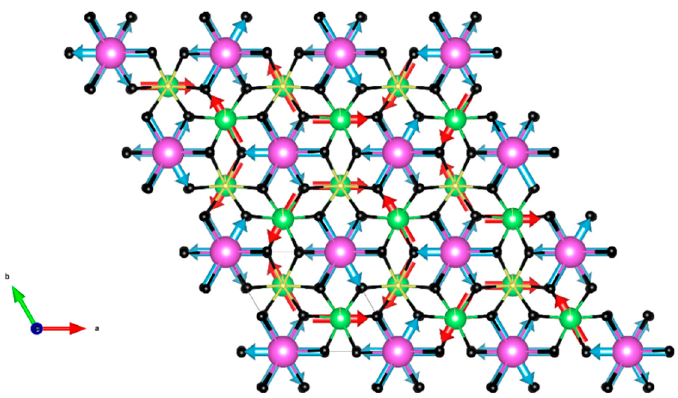
Figure 6. The ball-and-stick representation [20] of the crystal structure of GdFeTeO 6 . Purple, green, gray and black spheres are Gd, Fe, Te and O ions, respectively. Blue and pink arrows highlight the clockwise and anticlockwise arrangements of spins in different magnetoactive layers. Supplementary Materials: The following are available online at https://www.mdpi.com/article/ 10.3390/ma14205954/s1, Figure S1. Comparison of the two XRD patterns of nominal “GdFeTeO 6 ” taken in CuK α radia-tion. Upper panel: Relatively pure phase prepared from oxides for 48 h at 700 ◦ C [5]. Lower pan-el: mixed phase prepared by the semi-wet method for 56 h at 750 ◦ C with three intermediate re-grindings (this work), Figure S2. Correlation between crystal radii [6] of RE 3+ and hexagonal subcell parameters of REFeTeO 6 . Red diamonds, a; blue triangles, c/2; RE = La [1, 3, 4], Pr, Nd, Sm [4], and Gd (this work); green circles, same from Reference [5], Figure S3. (a) Effect of changing UGd (eV) for the energy differences of one AFM and 3 FiM states with respect to the FM state. Changes of Gd UGd in the legend, with fixed UFe = 4 eV. (b) Energy difference between FiM1 and FM states. Effect of changing UGd and UFe, and comparison with HSE calculations (black line)., Figure S4. The comparison of Monte-Carlo calculations (solid lines) with the experimental tem-perature dependencies of mag- netic susceptibility (T) (left panel) and specific heat Cp(T) (right panel)., Table S1. Phase analysis results and hexagonal lattice parameters of GdFeTeO 6 samples prepared by various methods., Table S2. Details of the data collection and structure refinement., Table S3. Atomic coordinates and displacement parameters in GdFeTeO 6 , space group P 31 c , Table S4. Atomic coordinates and displacement parameters in GdGaTeO 6 , space group P 31 c